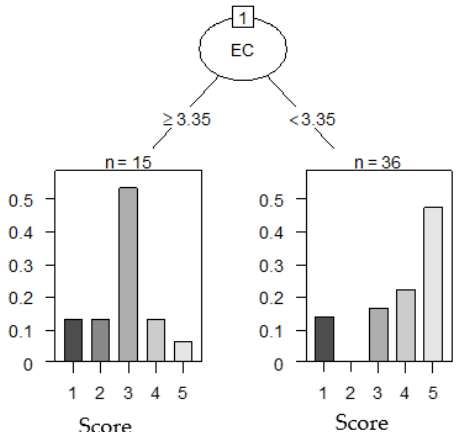
Figure 2. Classification and regression tree (CART) analysis of the airag properties (electrical conductivity (EC), pH, concentrations of minerals (Ca, P, S, Mg, K, and Na)) affecting the taste score of airag . Trees were pruned based on the complexity parameter corresponding with the smallest cross-validated error. Table 1. Comparison of the mean values of the properties of airag between high-score (4~5 points) group and low-score (1~3 points) group, and the overall means in the samples. N